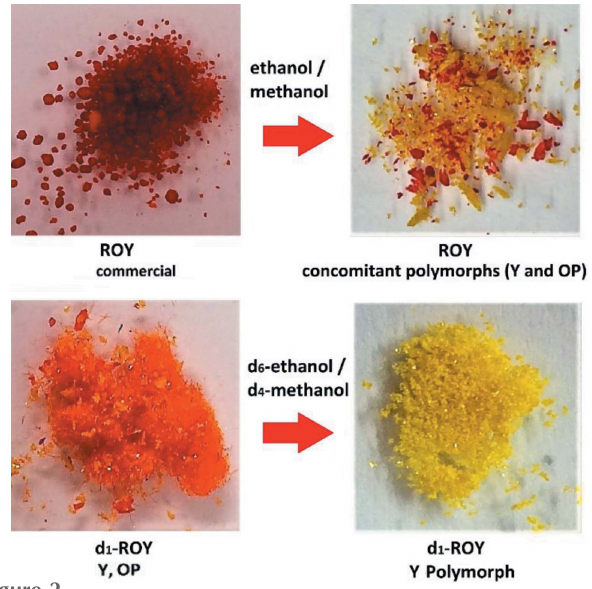
ROY distance (A˚ ) d 1 -ROY distance (A˚